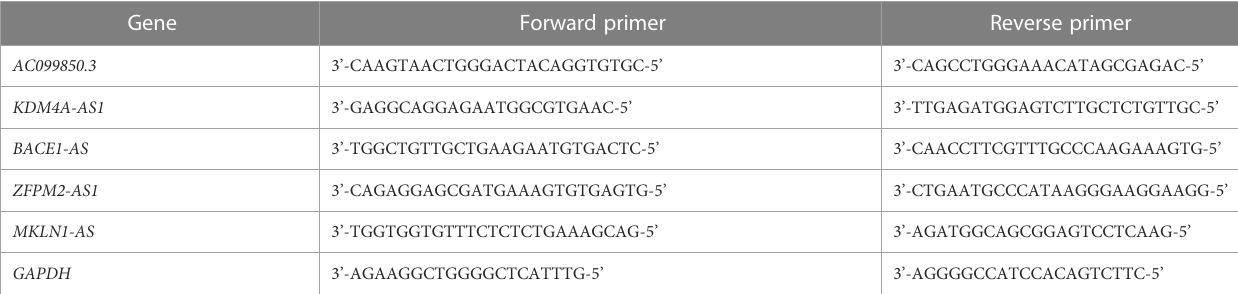
TABLE 1 Primers for